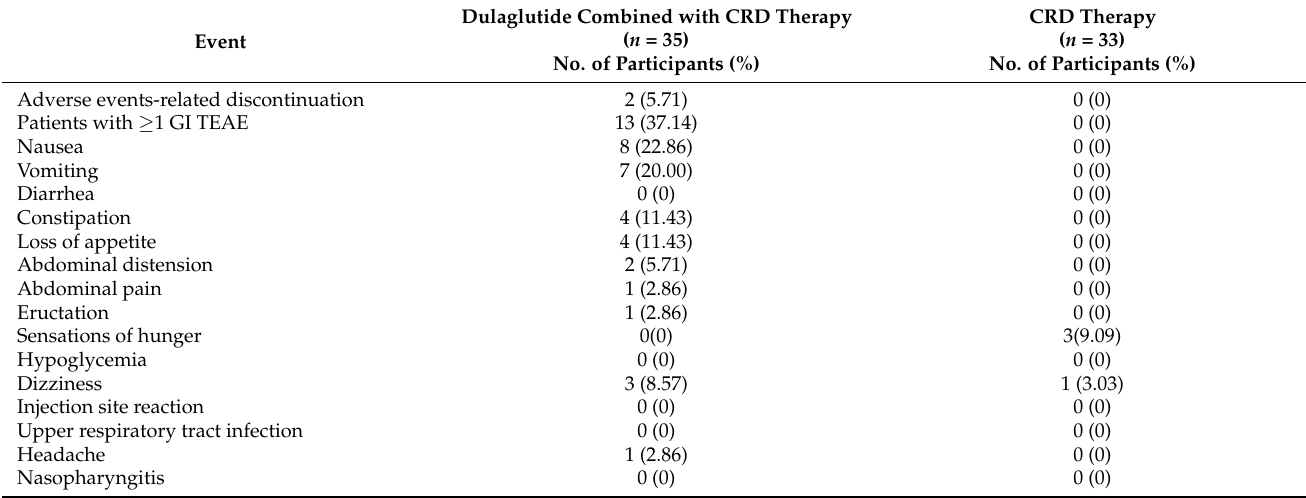
Table 3. Adverse events and safety data during the treatment in two